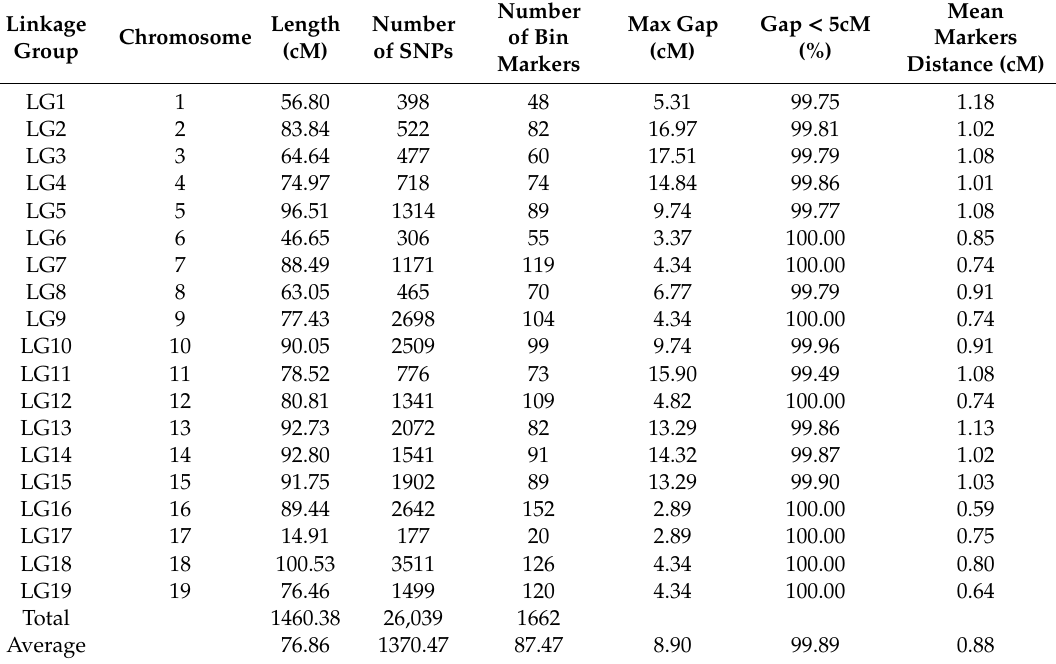
Table 4. Characteristics of the linkage groups of the integrated genetic